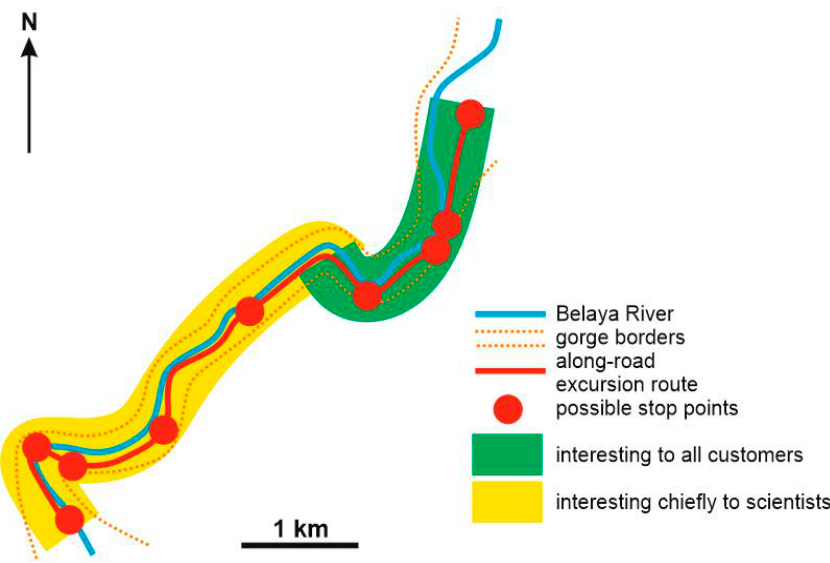
Figure 7. A tentative zonation of the Granite Gorge geosite depending on the expected customer preferences.